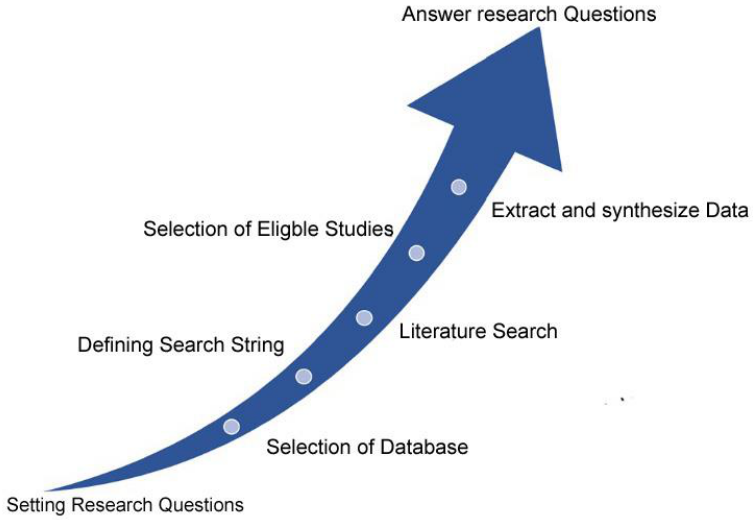
Figure 2. Steps involved in planning a systematic literature review